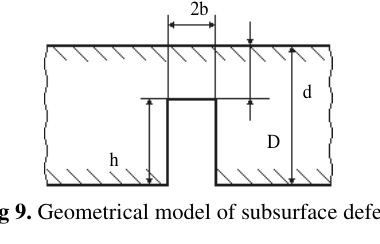
Fig 9. Geometrical model of subsurface defect